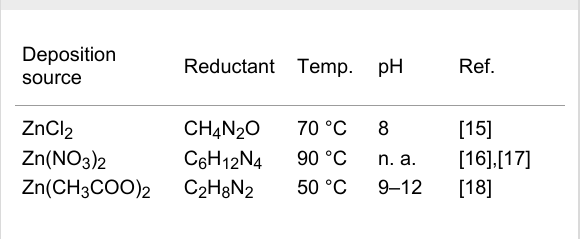
Table 1: ZnO films prepared in aqueous solution.